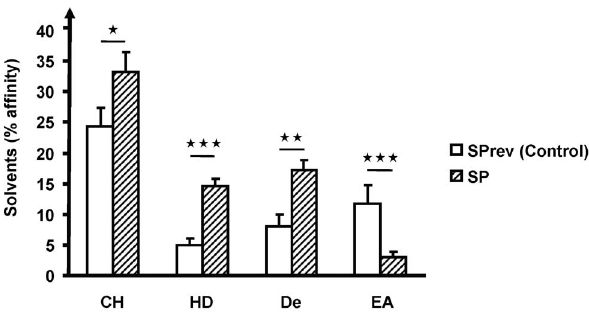
Figure 6. Effect of Substance P reverse (SPrev) and Substance P (10 2 6 M) on the affinity of Bacilluscereus to solvents of different polarities. chloroform (CH), hexadecane (HD), decane (De) and ethyl acetate (EA) ( w = P , 0.05 , ww = P , 0.01 , www = P , 0.001 ). Each value represents the mean 6 SEM of three independent experiments.